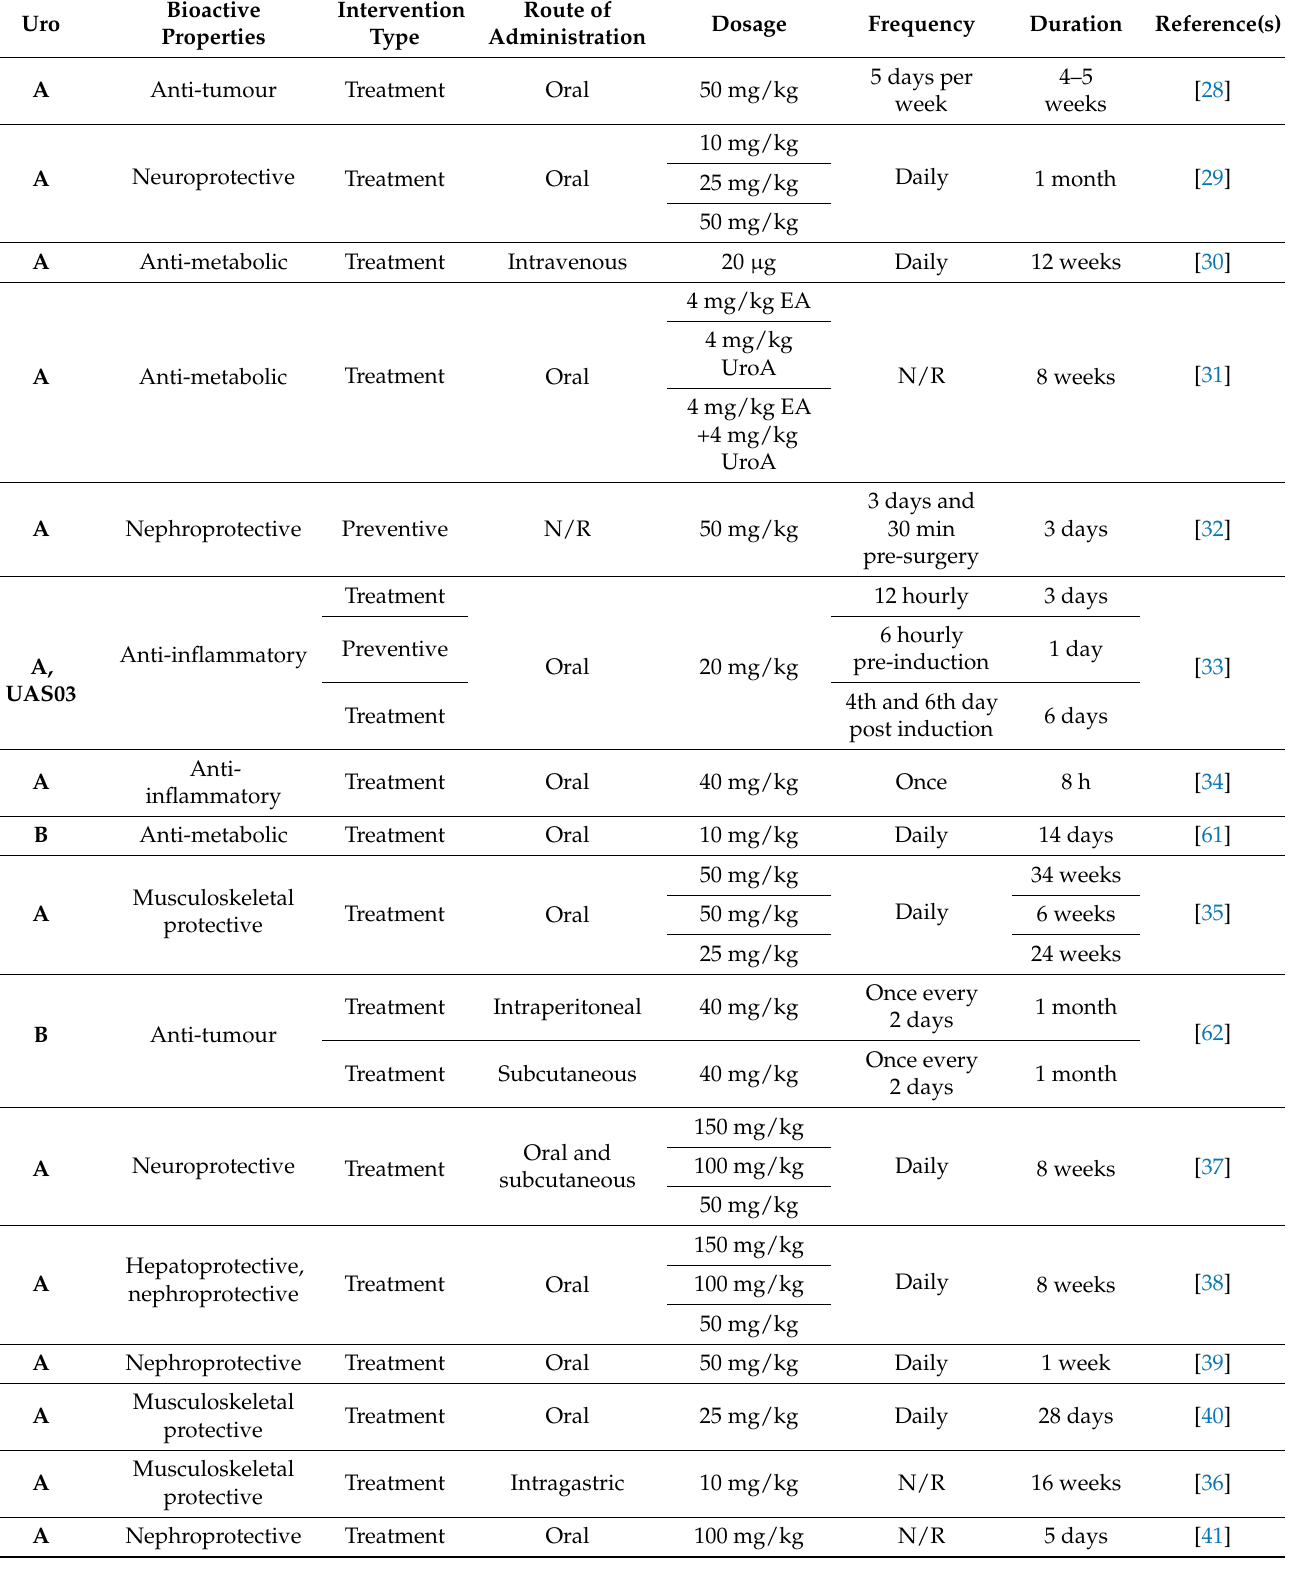
Table 1. Types of urolithin, bioactive properties, intervention type, administration route, dosage, frequency, and duration of the